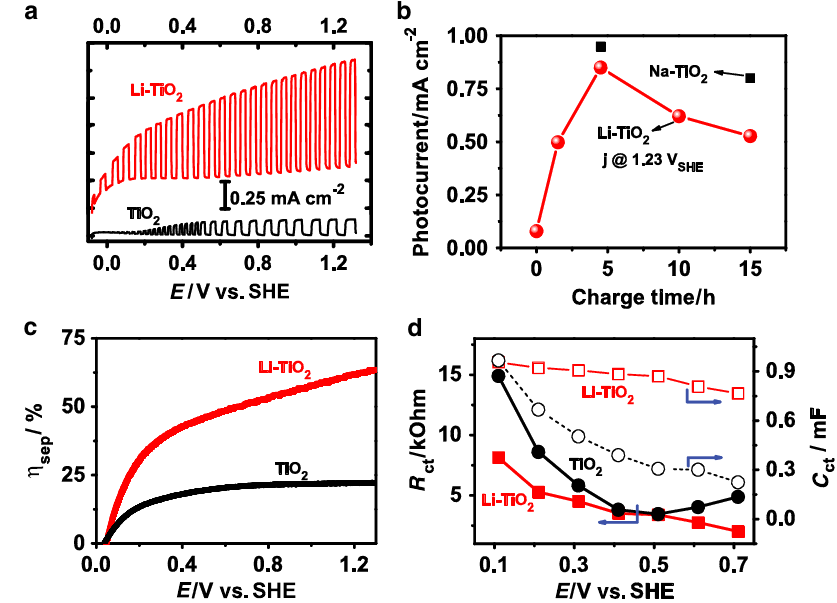
Fig. 6 The electrochemical properties of the photoanodes. a The photocurrent density of (black) TiO 2 and (red) Li-TiO 2 under chopped light. b The photocurrent of TiO 2 photoelectrode as a function of the duration of Li-ion or Na-ion insertion process. c Comparison of the charge separation ef fi ciency of TiO 2 and Li-TiO 2 photoanodes estimated in electrolyte of 0.5 M Na 2 SO 4 + 0.5 M H 2 O 2 solution. d Charge transfer resistance ( fi lled dot) and capability (empty dot) of TiO 2 (black square) and Li-TiO 2 (red circle)